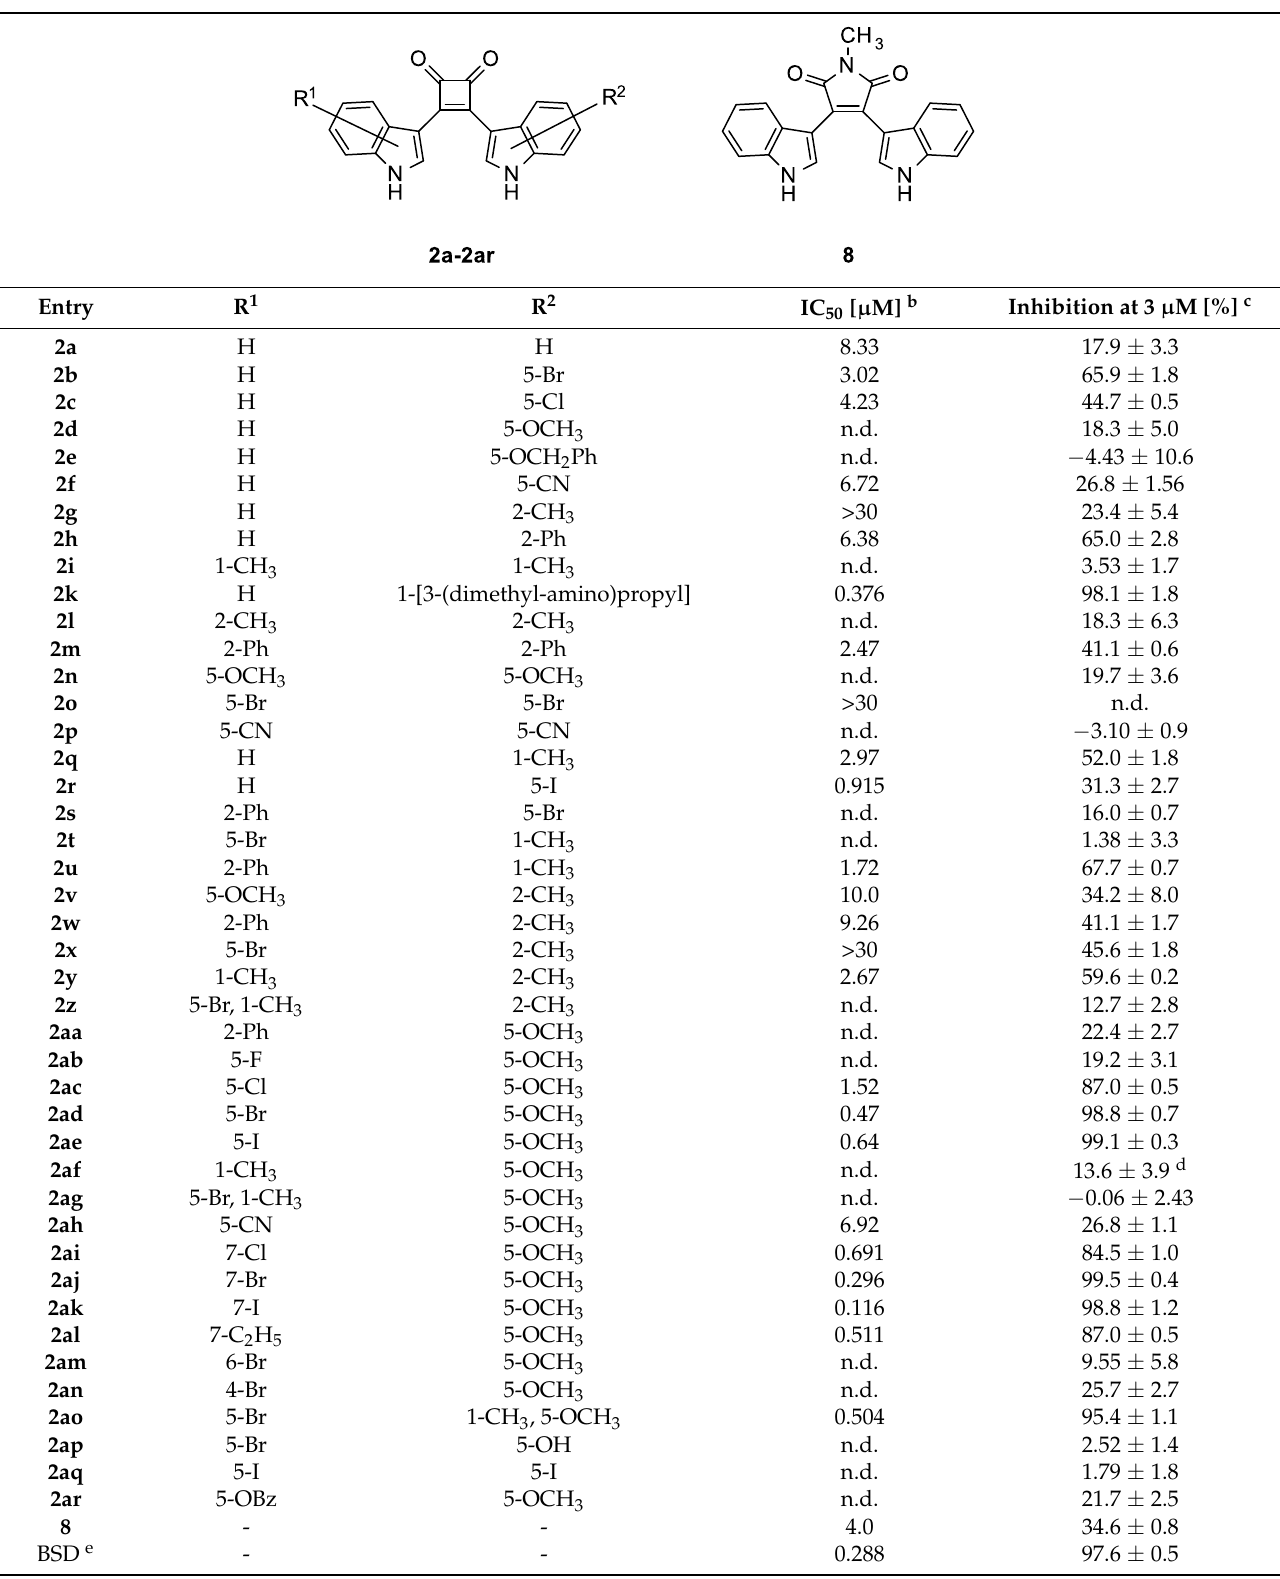
Table 1. Structures and antiplasmodial activity of bisindolylcyclobutenediones 2a – ar and bisindolylmaleimide 8 a .